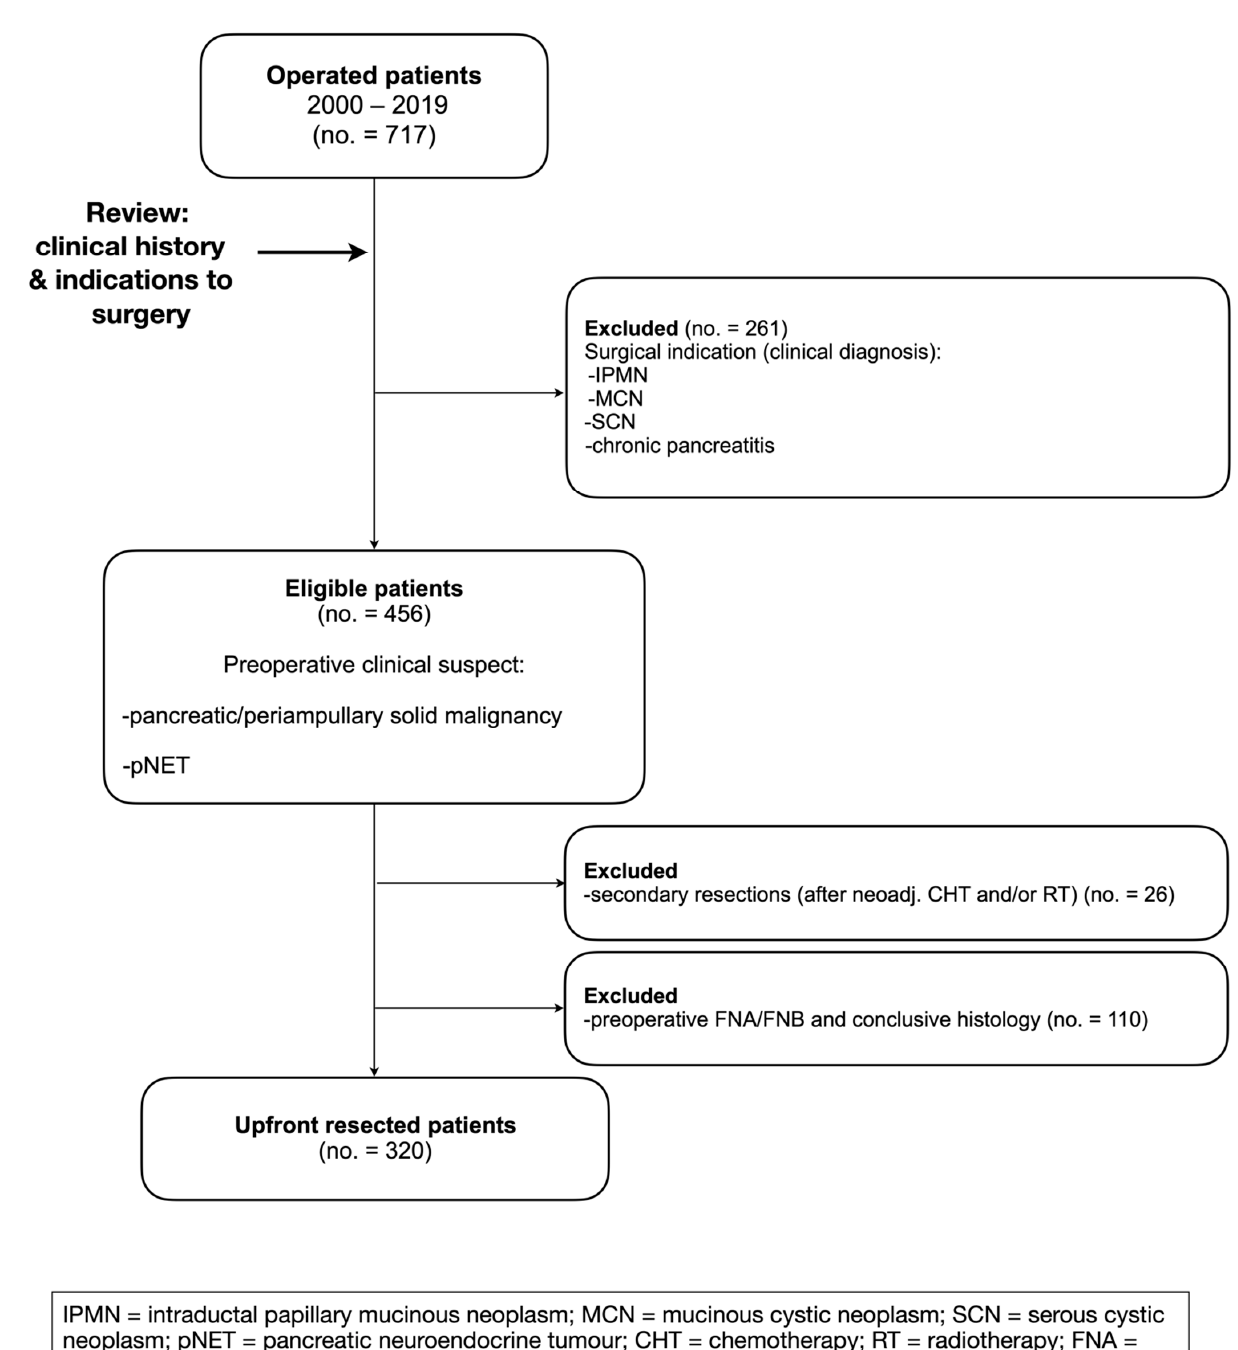
Figure 1. Inclusion and exclusion criteria.